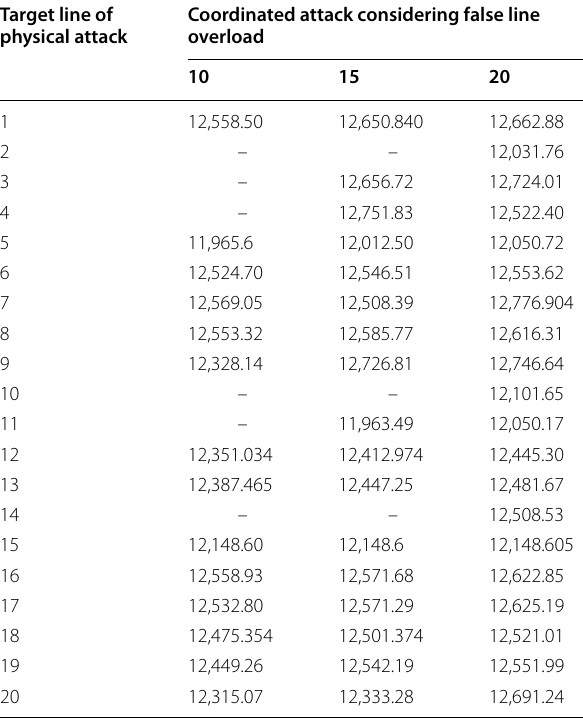
Table 4 Attack effects of coordinated attack under different attack